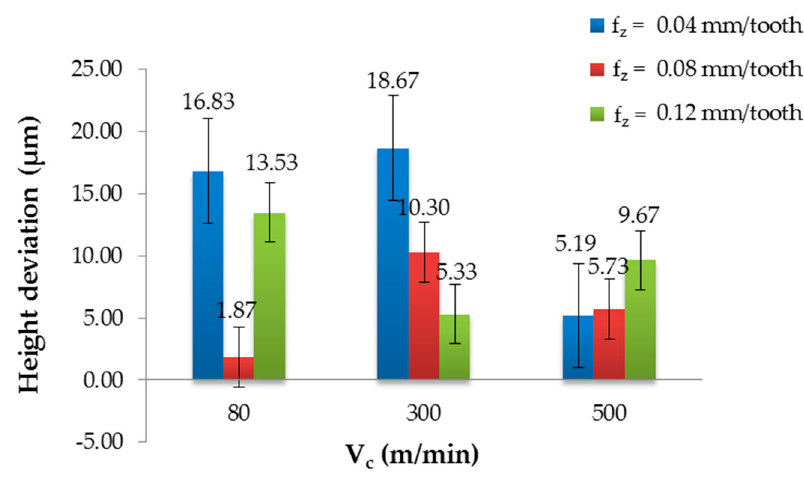
Figure 4. Height deviation in relation to the cutting speed after milling with different feeds and a non-coated tool.